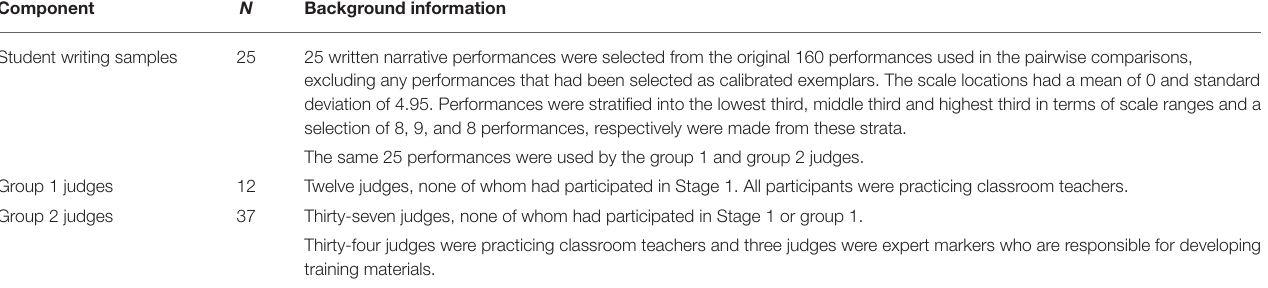
TABLE 1 | Overview of the design of Stage 2.